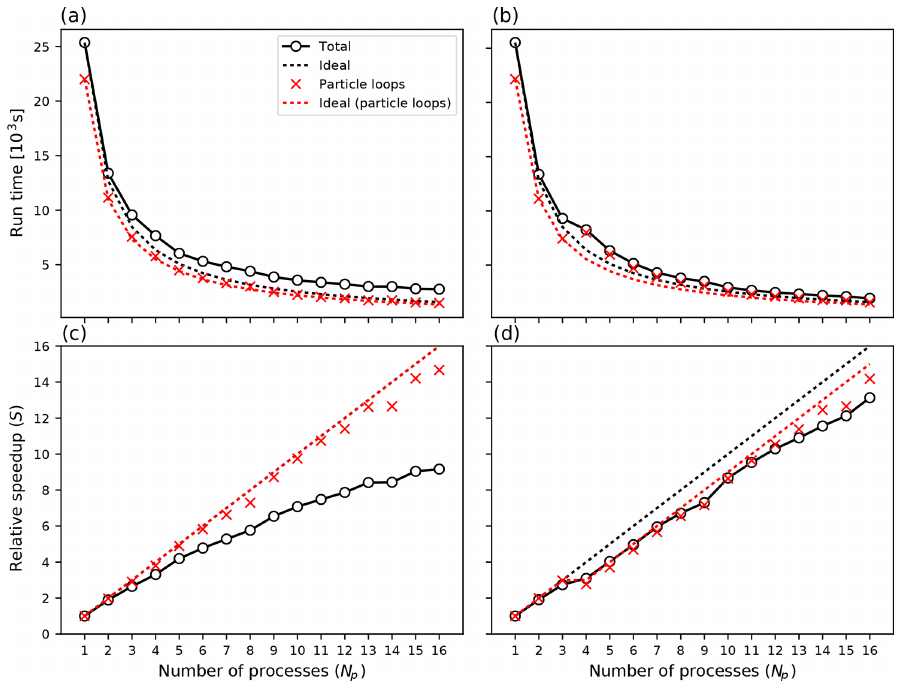
Figure 7. Computational time (a, b) and speedup (c, d) for up to 16 processes on a single node. In panels (a, c) , all processes read meteoro- logical input data, whereas in panels (b, d) , a dedicated process reads and distributes input data for N p ≥ 4.